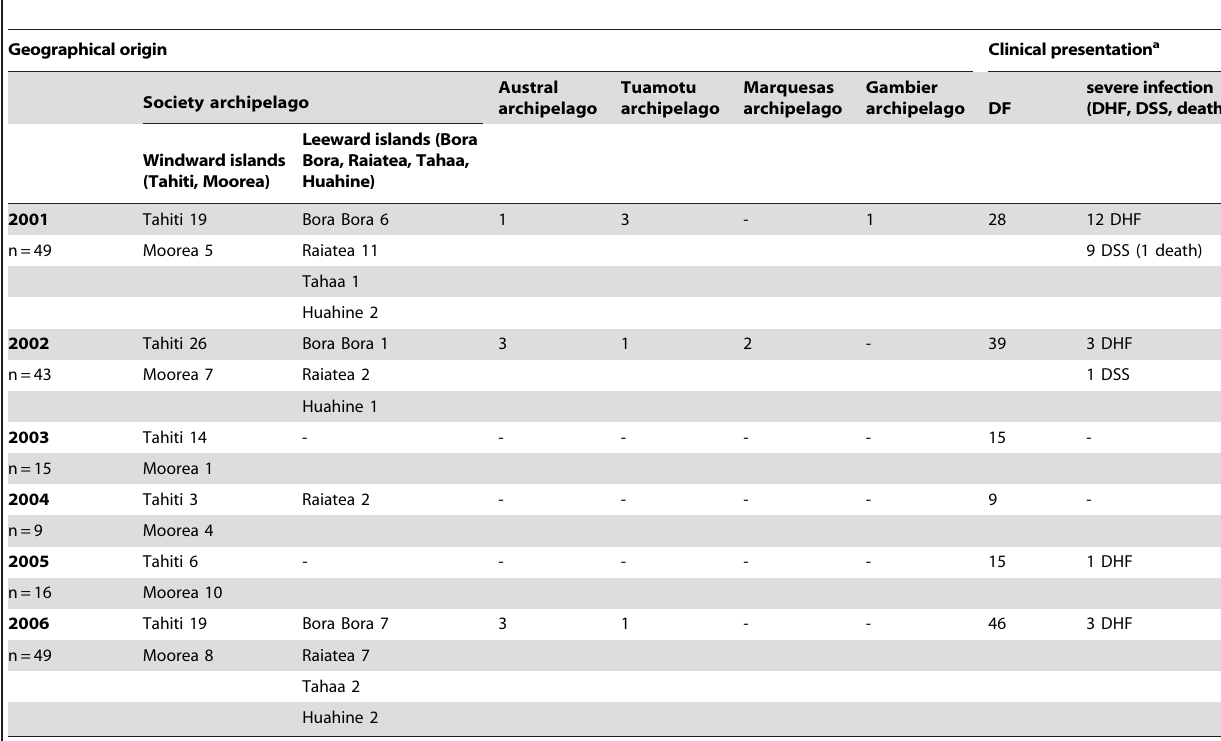
Austral Tuamotu Marquesas Gambier archipelago archipelago archipelago archipelago DF